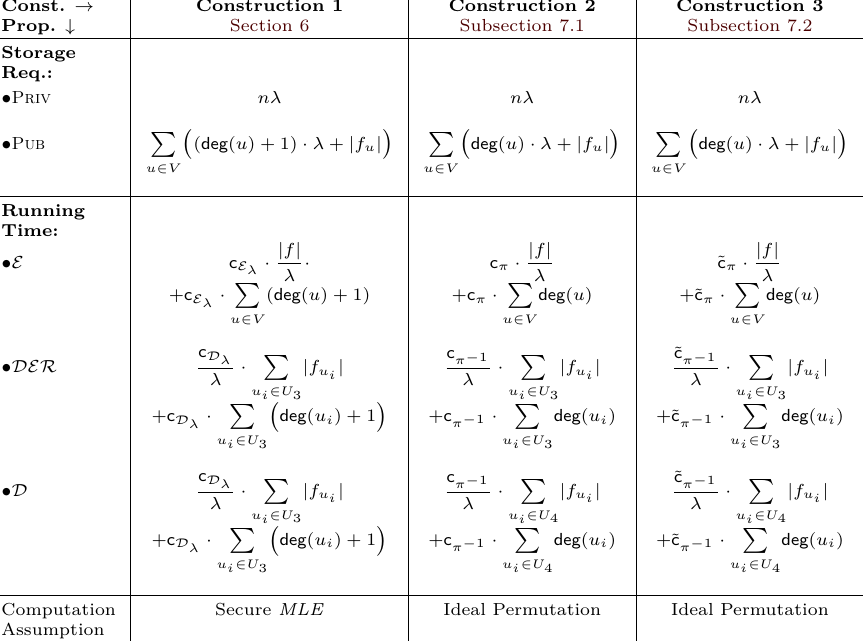
Table 3: Comparison table for KAS-AE schemes built in Section 6 and Section 7. Const.